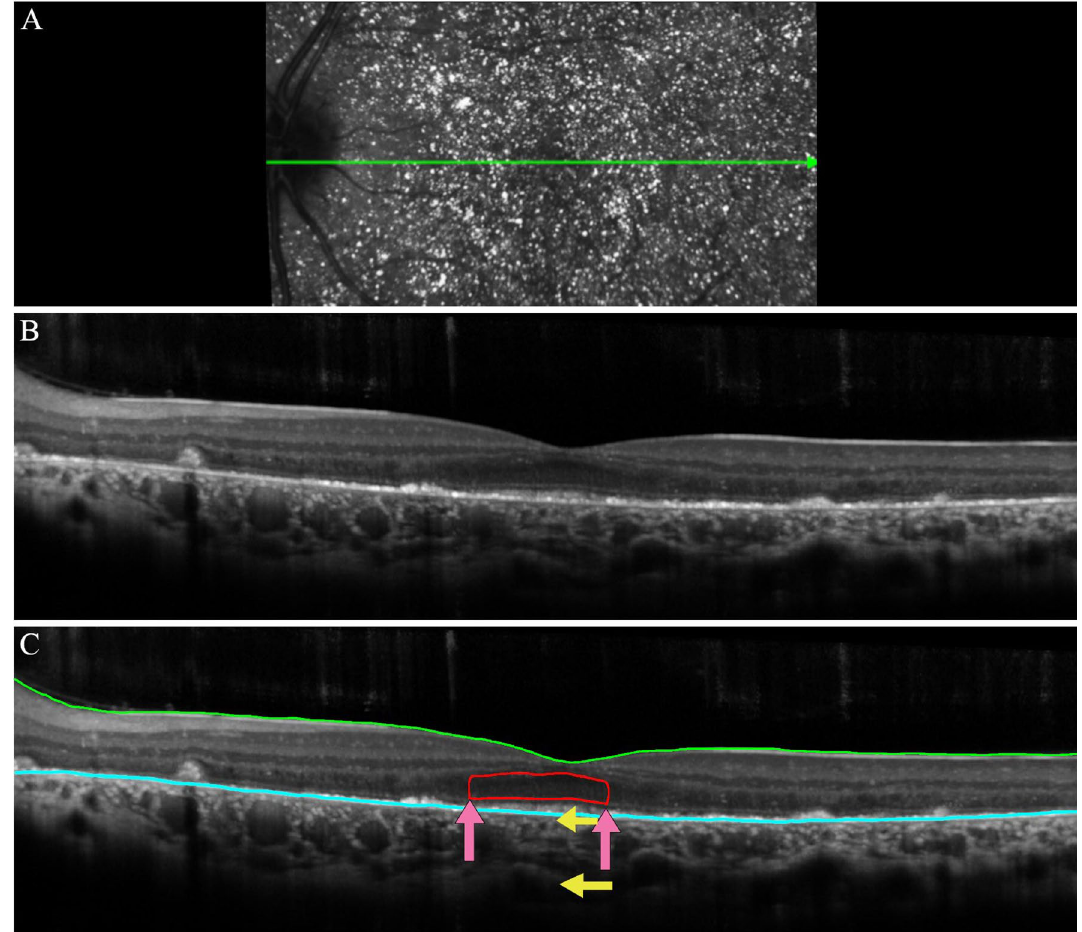
Figure 1. Spectral domain-optical coherence tomography (SD-OCT) imaging for patient 4 (P4). ( A ) The fundus view of the horizontal scan through the fovea of the spectral domain-optical coherence tomography (SD-OCT) for P4. The green line in the IR-R image indicates the position of the SD-OCT scan ( B ) Horizontal foveal scan. ( C ) A segmented line scan where the green line indicates the internal limiting membrane. The blue line indicates Bruch’s membrane. The red outlined portion is the outer nuclear layer + area (ONL + area). The pink arrows indicate the extent of the intact EZ band. The yellow arrows indicate the top and bottom of the choroid where the thickness was